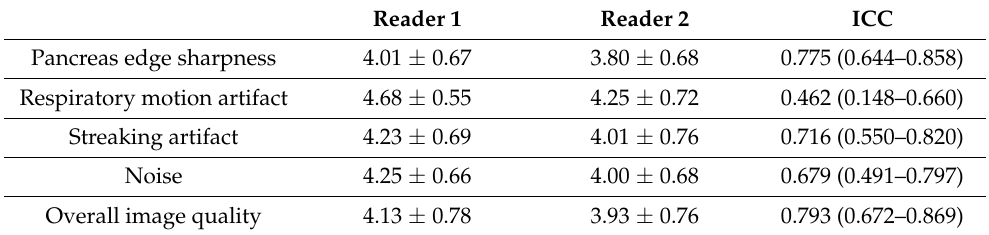
Table 3. Qualitative image quality analysis of dynamic contrast-enhanced images.